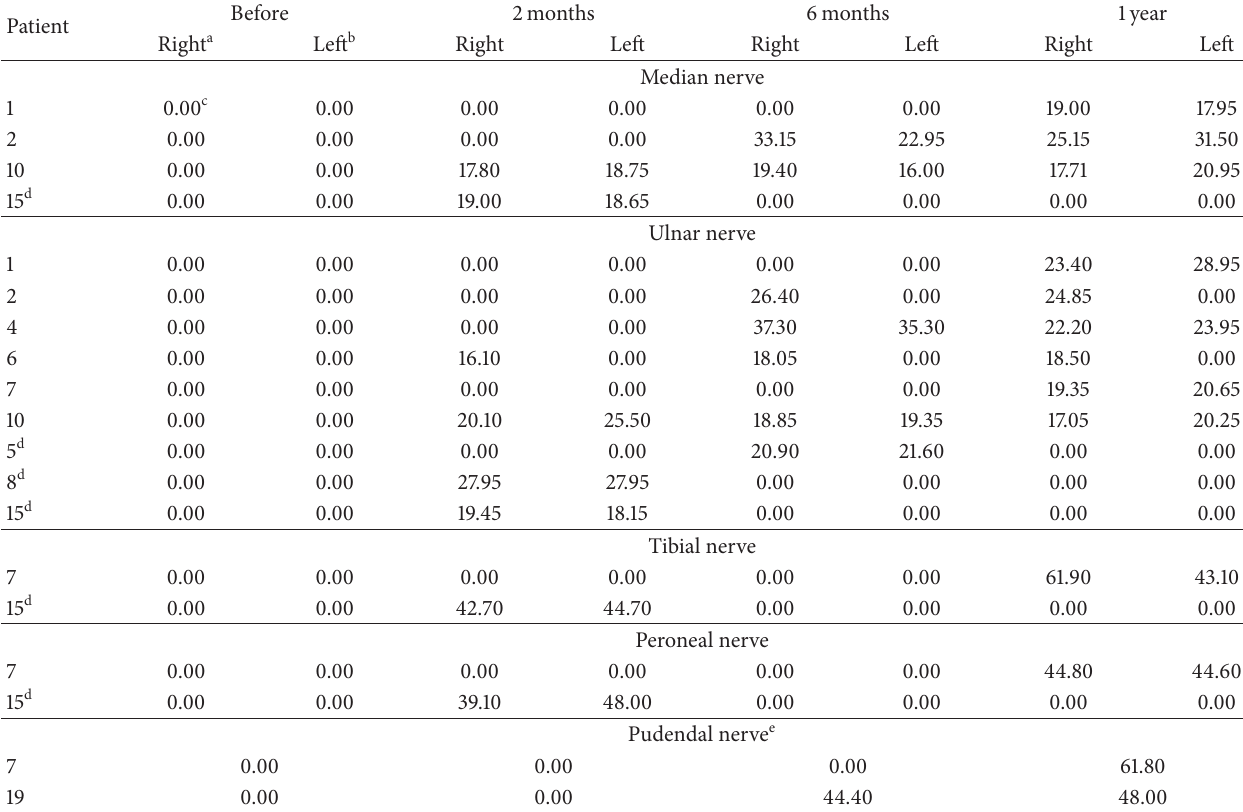
Table 10: Latency measured by evoked potentials of the upper and lower limbs in patients with cervical SCI who showed response of SSEP over 1 year after hNSPC